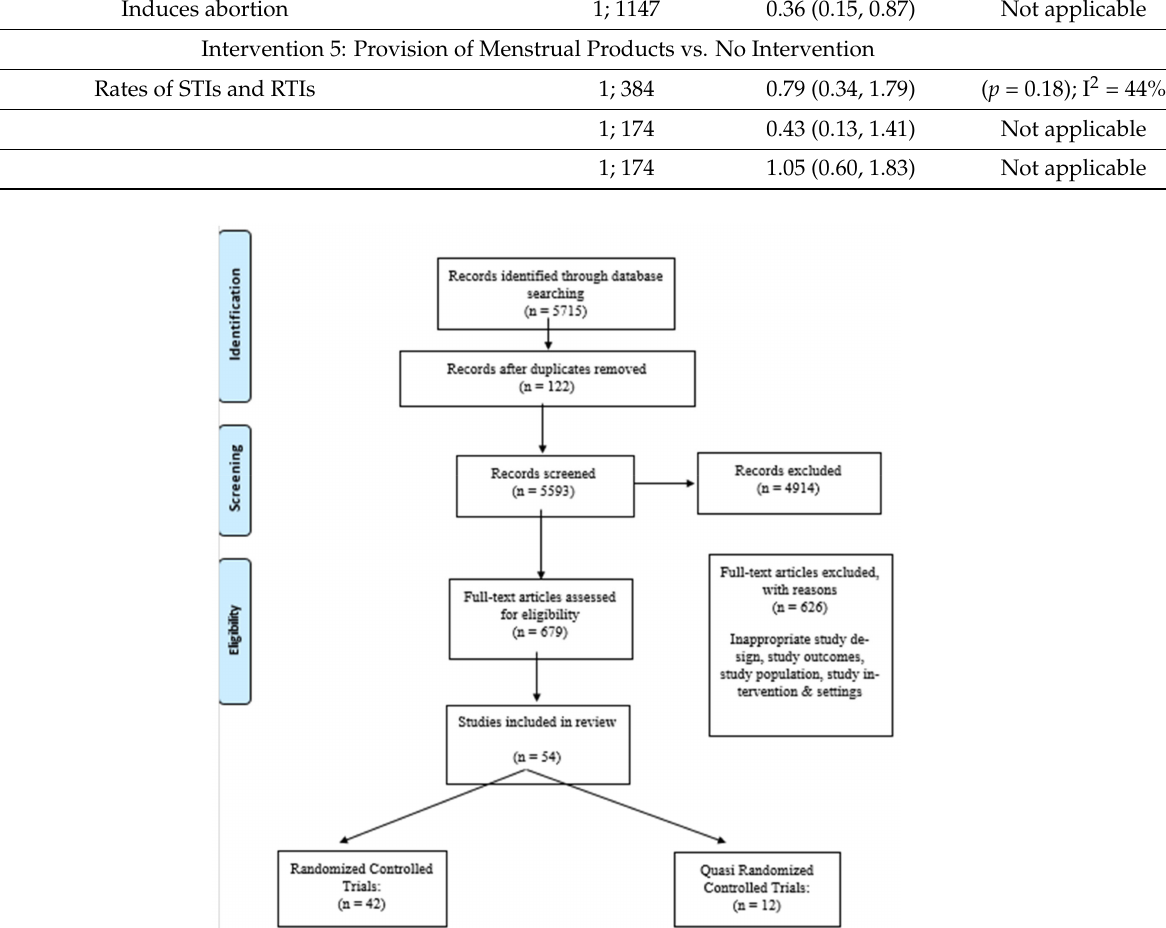
Figure 1. PRISMA Flow diagram for interventions to improve Adolescent Sexual and Reproductive Health and Rights (Adapted from Moher et al.